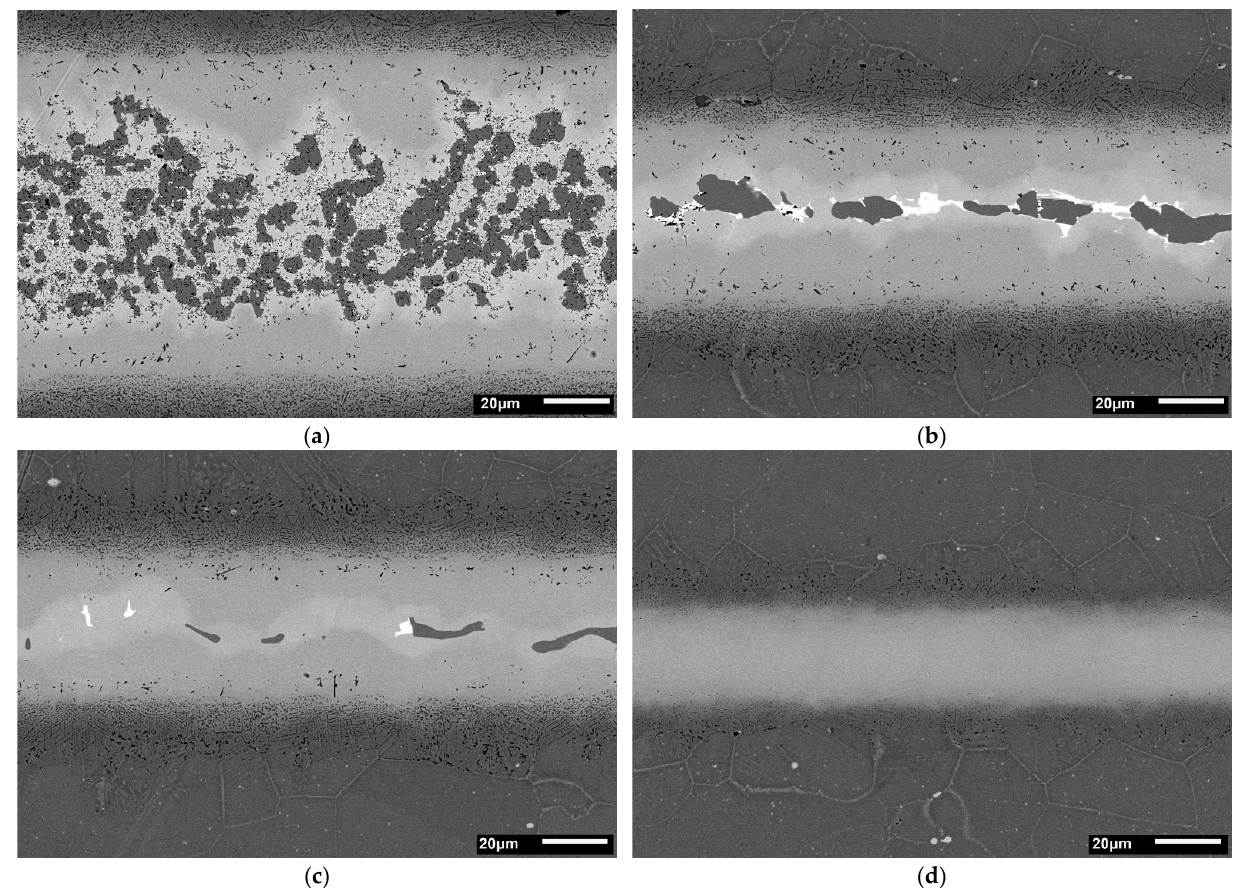
Figure 5. Structures of Hastelloy X–Palnicro 36M joints obtained after 30 min brazing at 995 °C for different gap sizes, approximately 90 µ m ( a ), 55 µ m ( b ), 45 µ m ( c ) and 30 µ m ( d ).